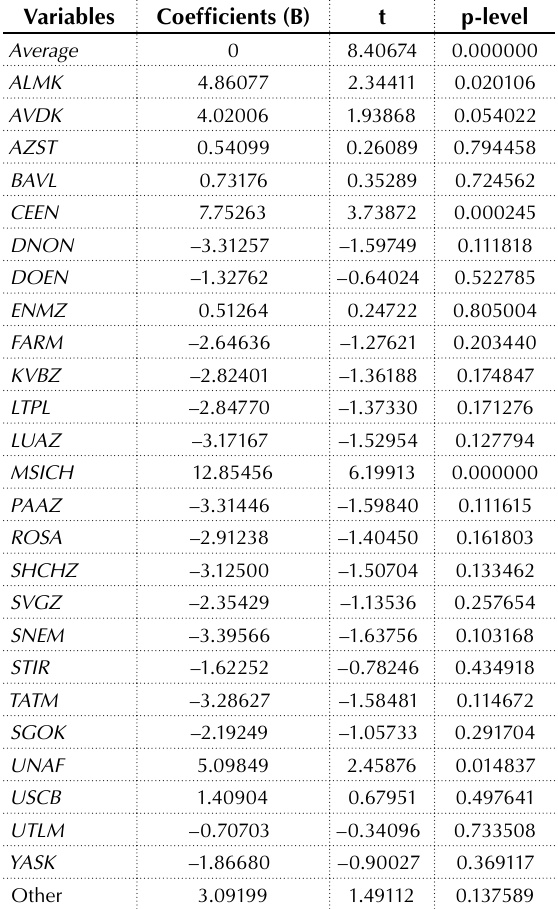
Table 5. Regression analysis results